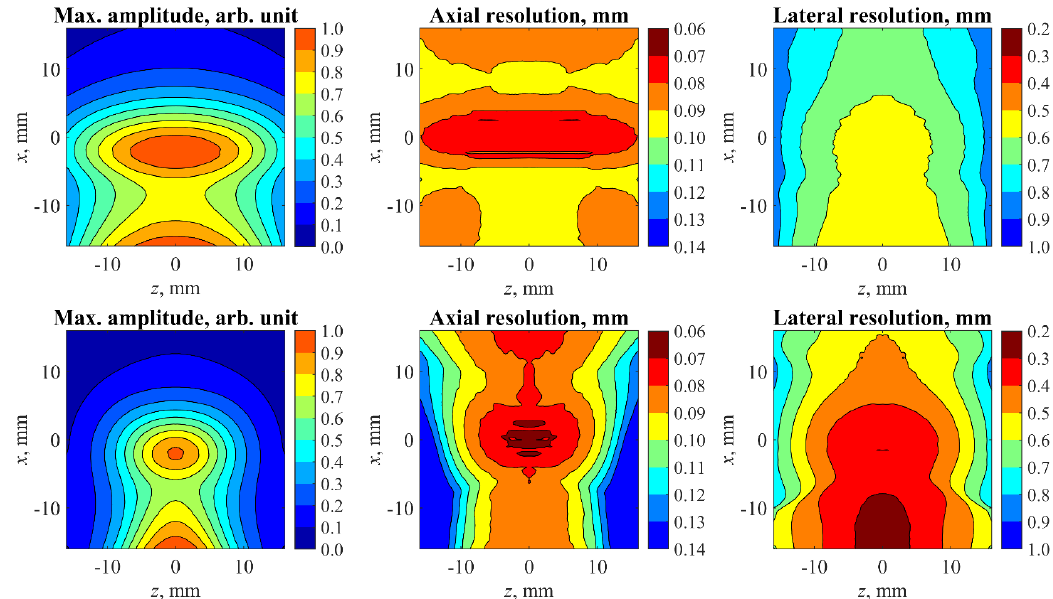
Figure 2. Sensitivity and spatial resolution maps 32 × 32 mm for a cylindrical ( top row) and spherical ( bottom row) arrays with 64 elements, 0.5 mm wide with 0.5 mm pitch and a curvature radius of 40 mm [83]. The sensor array is located below the maps symmetrically, with respect to the z = 0 mm line. The cylindrical sensor array is located at x = − 40 mm, and the center of curvature of the spherical array is x = 0 mm, z = 0 mm. Adapted with permission from [83], Springer Nature, 2018.